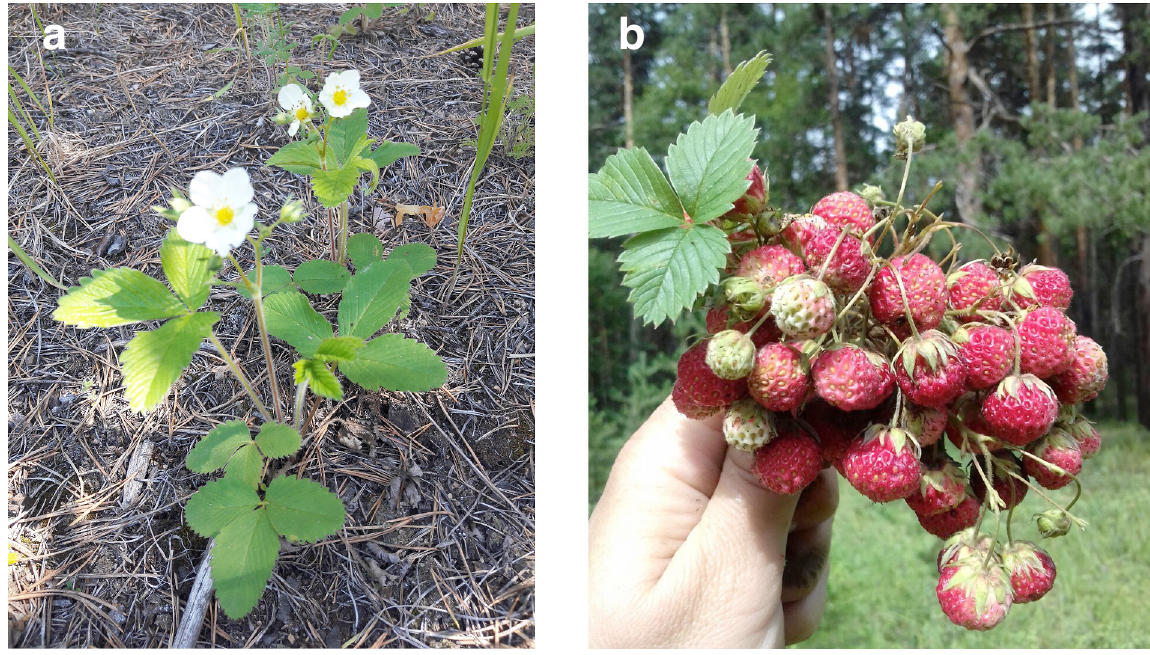
Fig. 1: Fragaria viridis Weston is in the stage of full blooming ( a ) and in the stage of fruiting ( b )